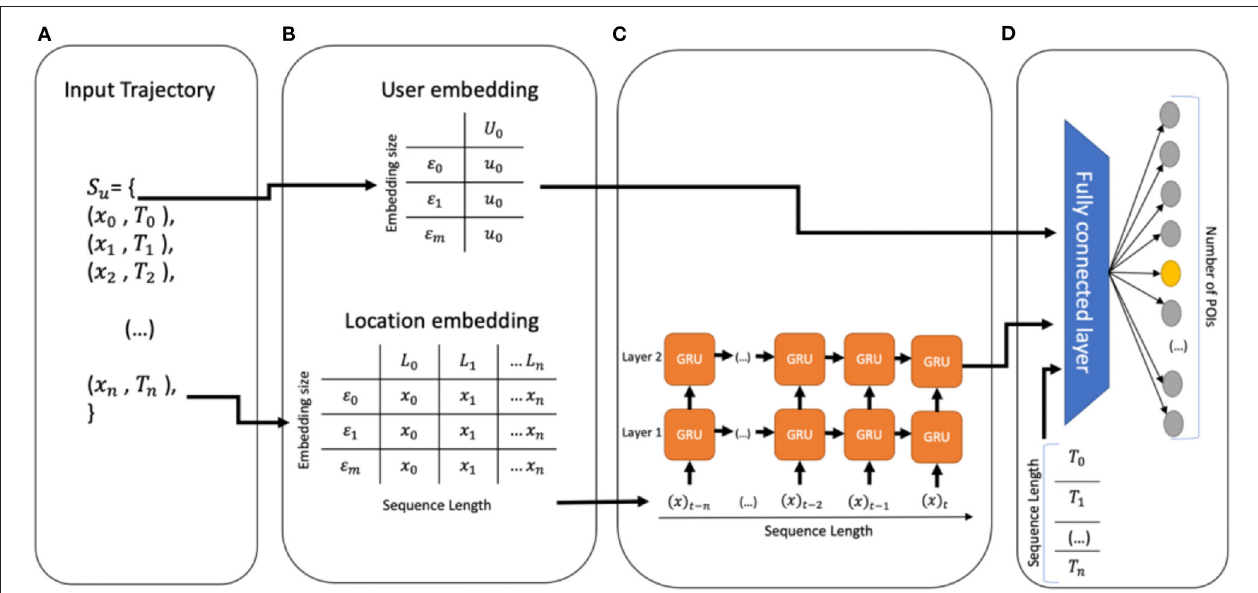
FIGURE 1 | (A) The input of the model, only spatial data is considered, (B) embedding phase, (C) multi-layer GRU, and (D) fully connected layer and output.